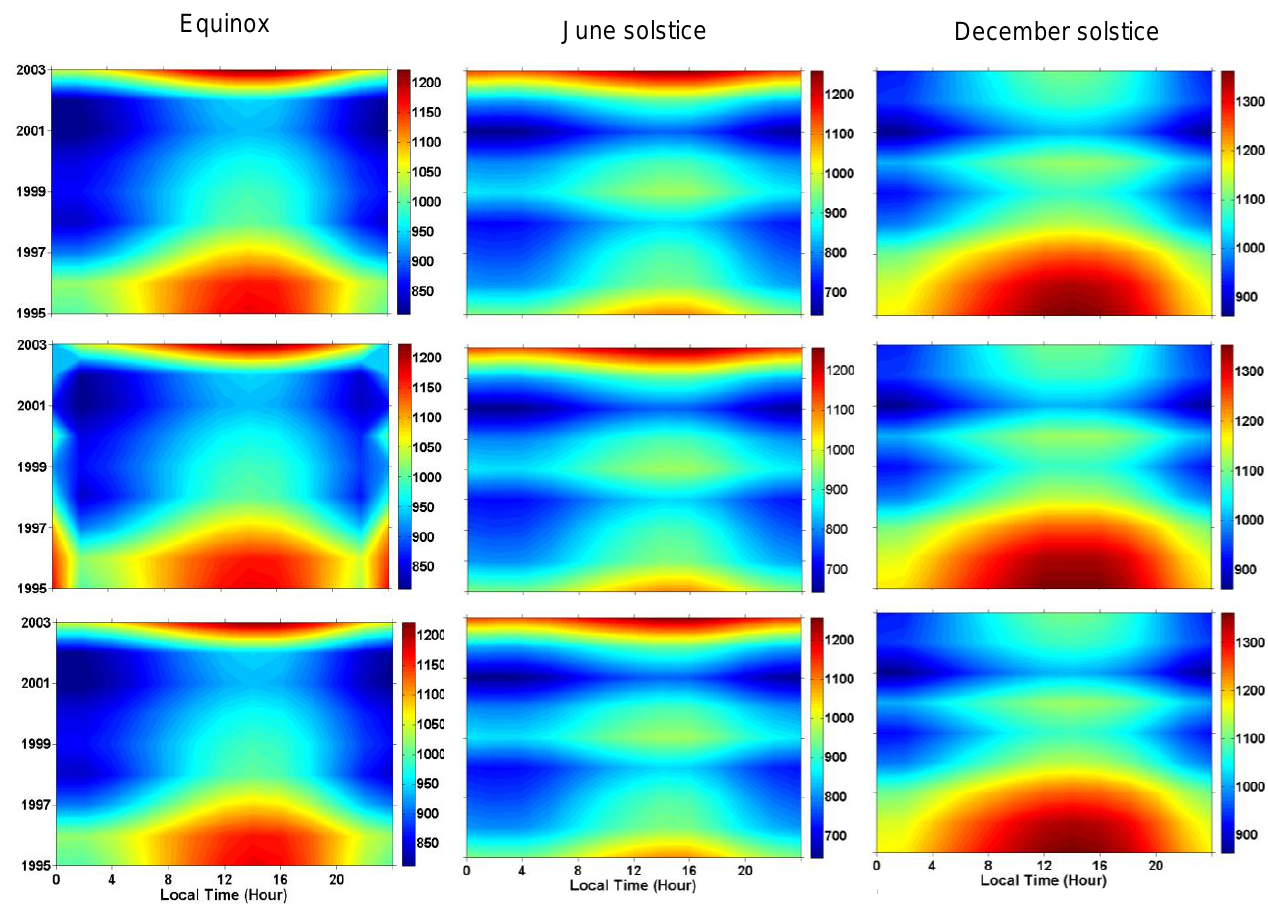
Fig. 6. Local time variation of neutral gas temperature at 550km altitude obtained from the MSISE 90 model for the period 1995 to 2003 for − 10 ◦ , 0 ◦ and 10 ◦ magnetic latitudes (from top to